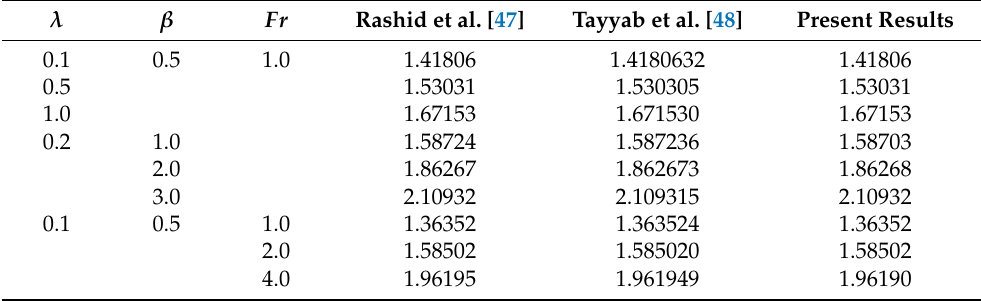
Table 3. Comparison for skin friction coefficient for various inputs of λ , β , Fr when ignored other parameters.